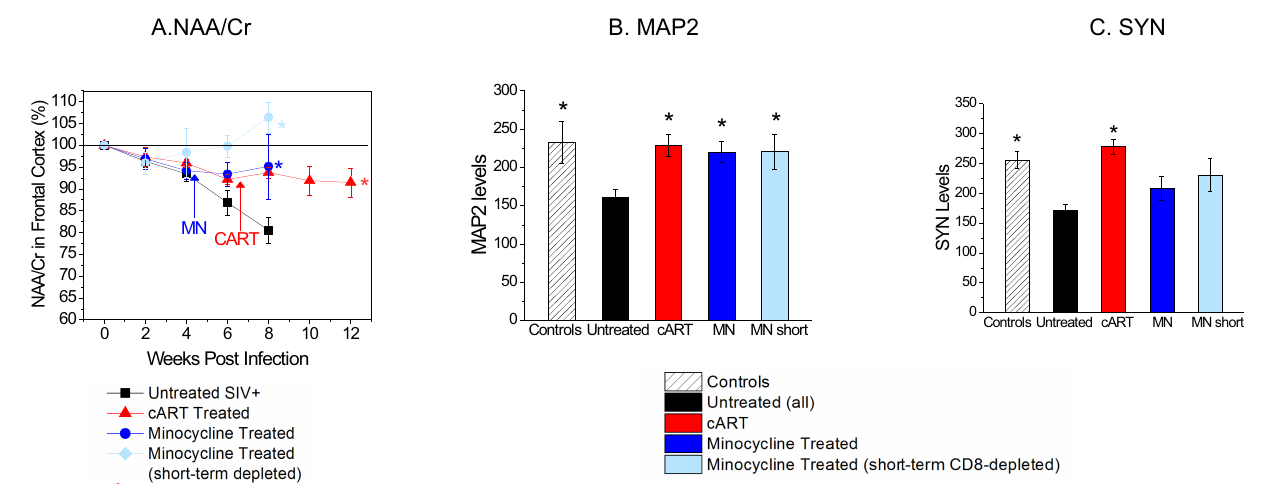
Fig 4. Viral RNA and neuronal markers (NAA/Cr, MAP2, and SYN) with and w/o treatments. A. The decrease in NAA/Cr was arrested with this regimen of combination antiretroviral treatment as well as minocycline treatment resulting in higher NAA/Cr levels when compared to untreated animals sacrificed at 8 wpi, (cART P = 0.09; MN persistent P = 0.029; MN short P = 0.0012). Animals that were minocycline treated and had partial immune reconstitution of the CD8 T cell population showed the best results. B. MAP2 levels in combination antiretroviral treated and in minocycline treated animals were significantly higher than untreated SIV-infected animals (cART P = 0.006; MN persistent P = 0.010; MN short P = 0.016). C. Similarly, SYN levels in combination antiretroviral treated animals were significantly higher than untreated SIV-infected animals (P = 0.002). ( (cid:3) indicates statistically significant differences when compared to untreated animal.).